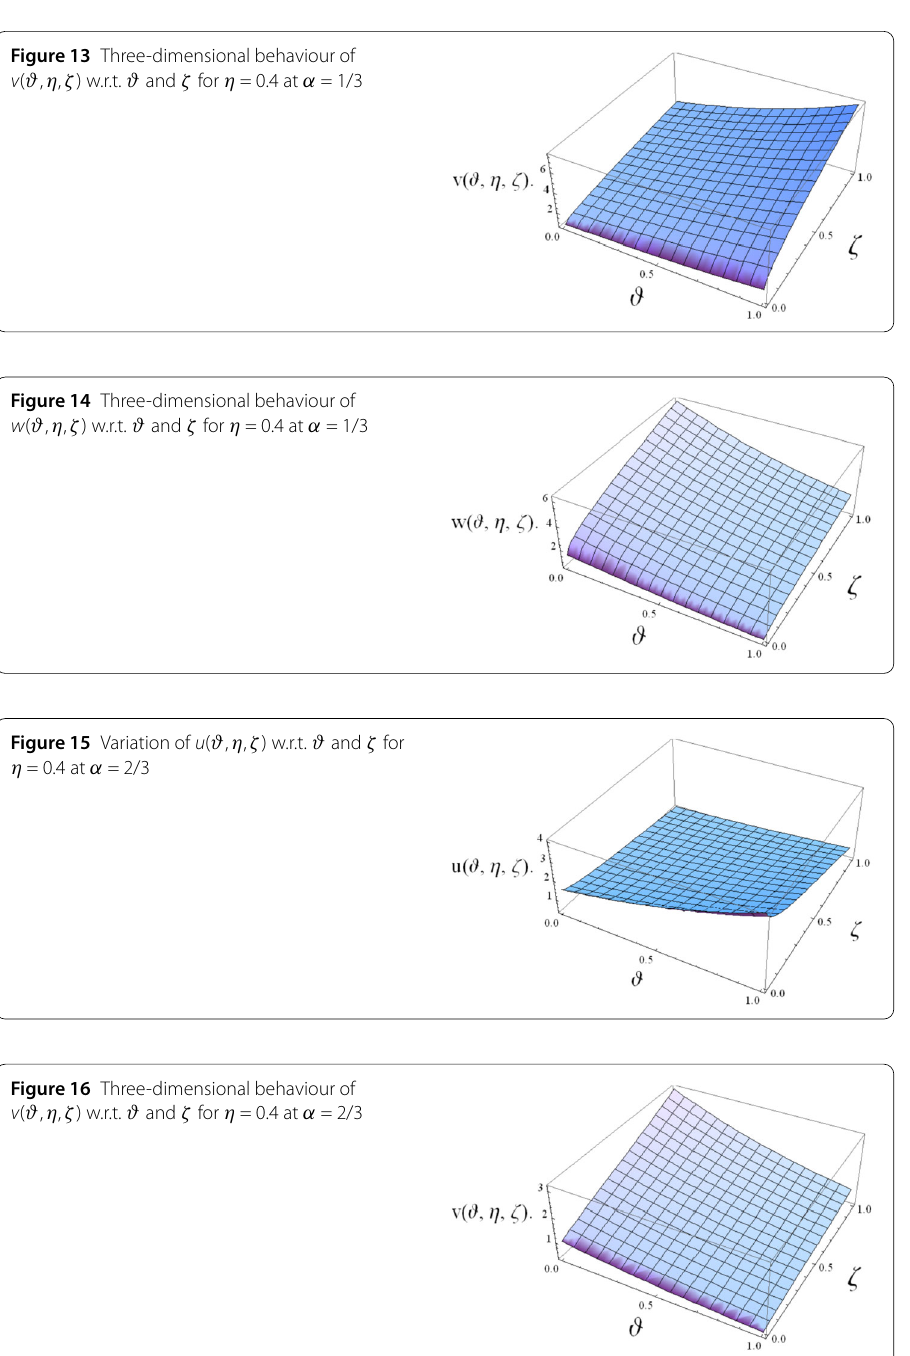
Figure 16 Three-dimensional behaviour of v ( ϑ , η , ζ ) w.r.t. ϑ and ζ for η = 0.4 at α =